Question: According to this chart, does the measure grow or shrink?
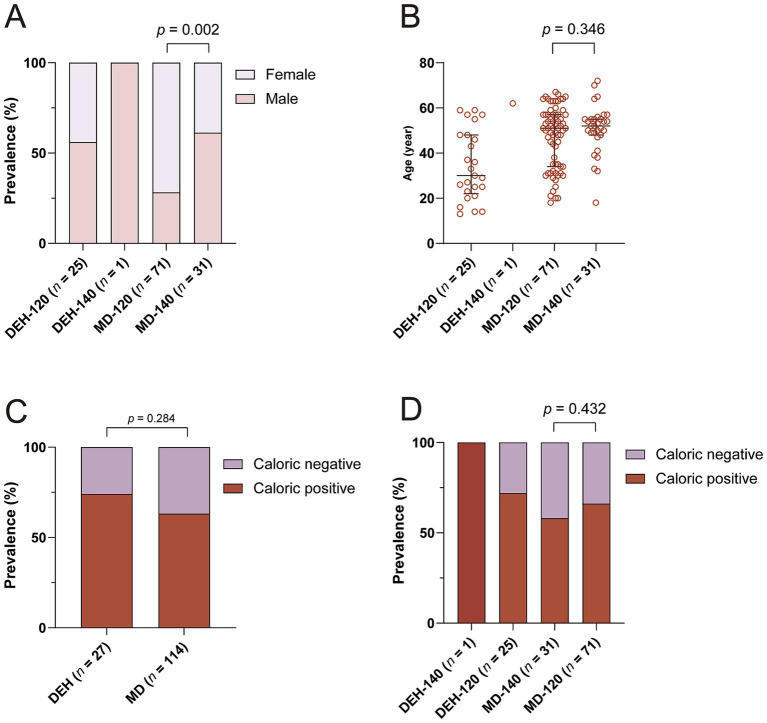
Answer: decreasing